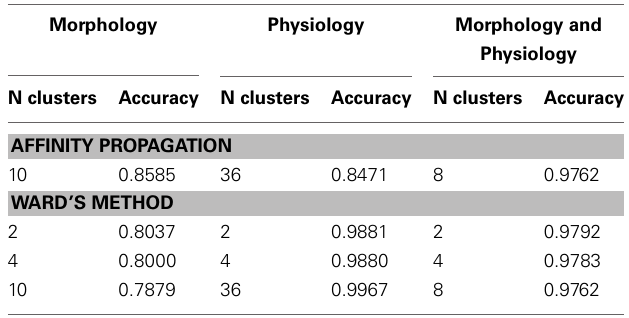
Table 6 | Affinity propagation vs. Ward’s method performance.